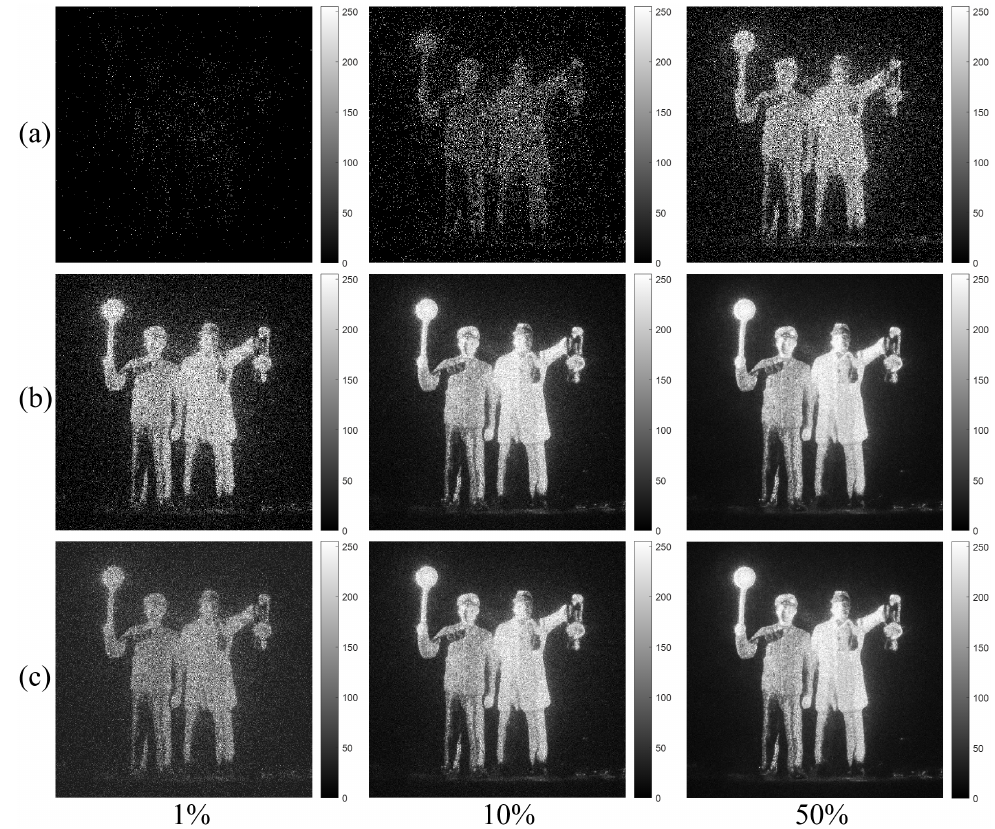
Figure 6. Estimated images with different expected photon ratios (1%, 10%, and 50%). ( a ) Single observation photon counting images, ( b ) N = 100 observation photon counting imaging by MLE and ( c ) N = 100 observation photon counting imaging by Bayesian estimation,